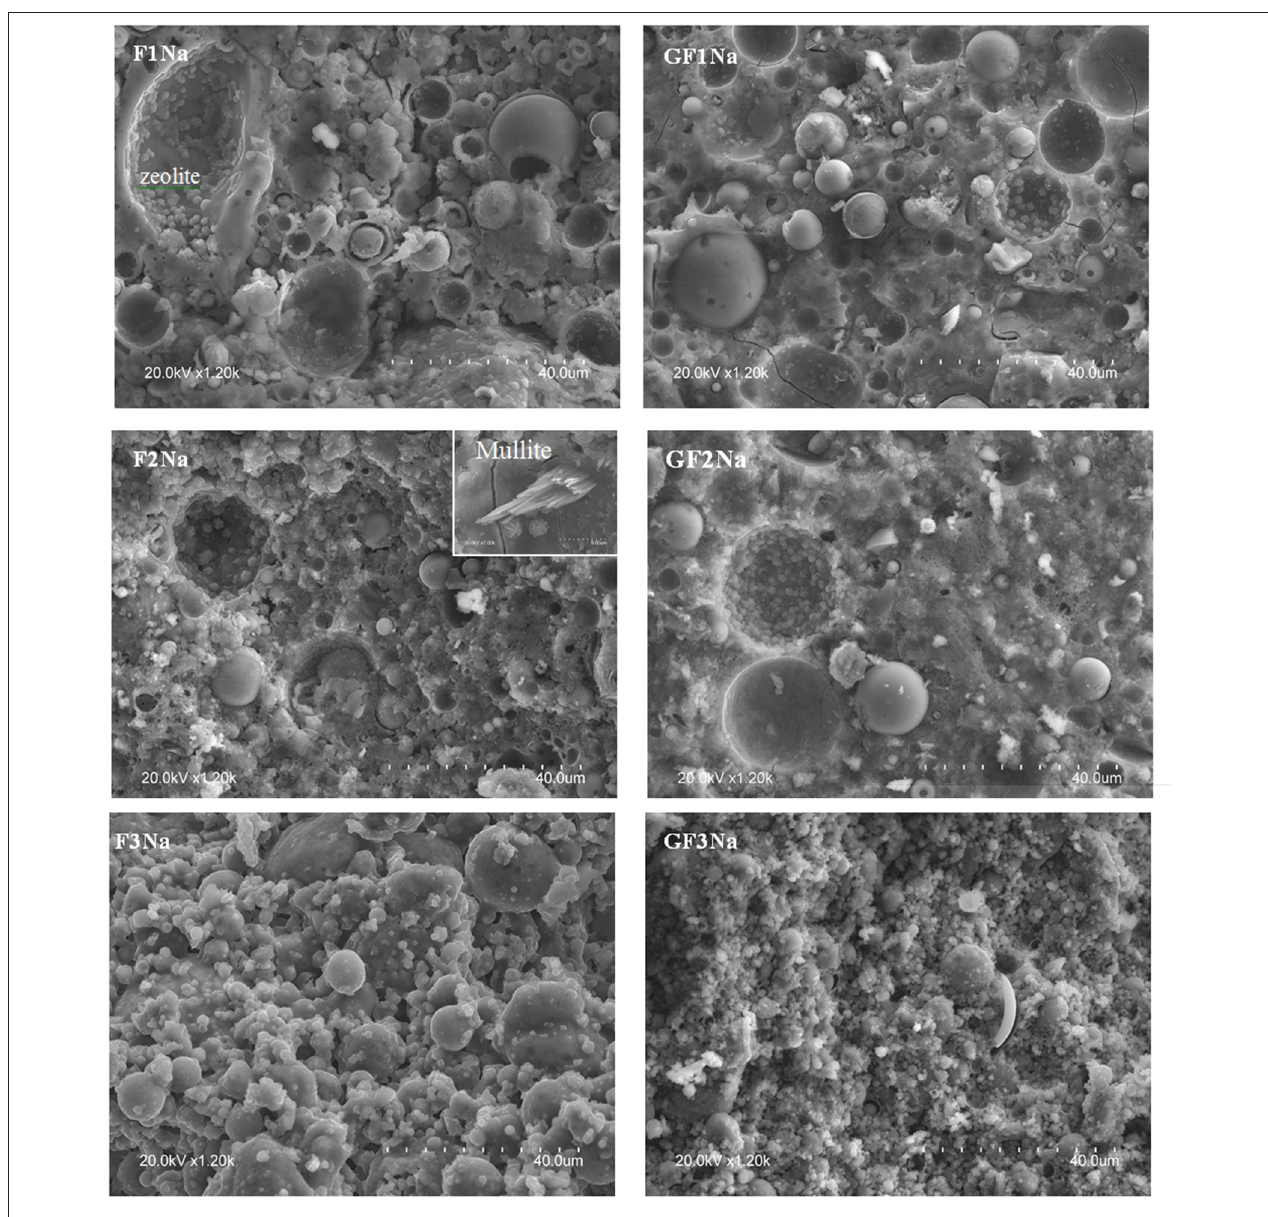
FIGURE 8 | SEM micrographs of